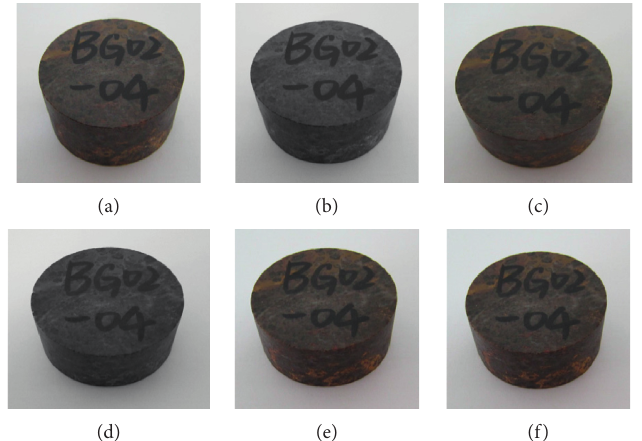
Figure 4: Morphology of rock freezing and thawing: (a) 0 F-Tcycles, (b) 20 F-Tcycles, (c) 40 F-Tcycles, (d) 60 F-Tcycles, (e) 80 F-Tcycles, and (f) 100 F-T